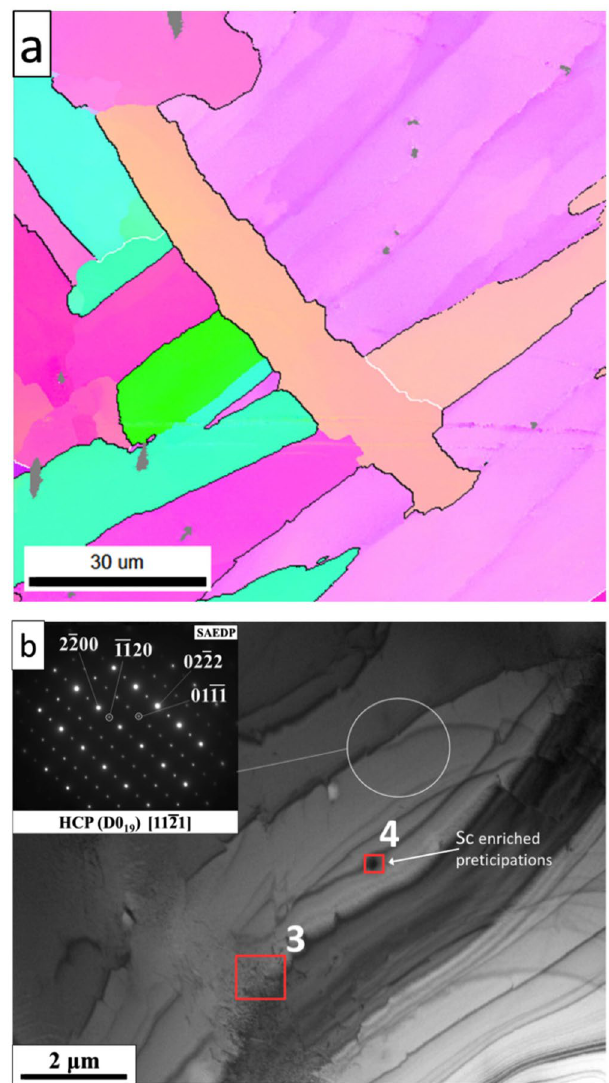
Figure 8. ( a ) Inverse Pole Figure (IPF) map after annealing, ( b ) TEM bright field images with SAED patterns and points of EDS analysis after annealing (cf. Table